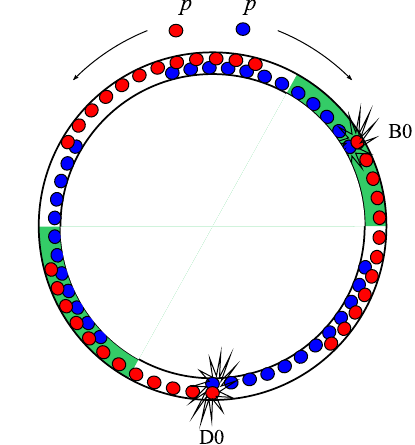
FIG. 6. (Color) The normalized growth rate of dipole motion in the simulated accelerator with impedance and chromaticity as a function of head-tail phase (cid:10) at three beam intensities demon- strating their linear relationship close to 0 and the near-universal relationship for head-tail phase between (cid:1) 1 and 0.